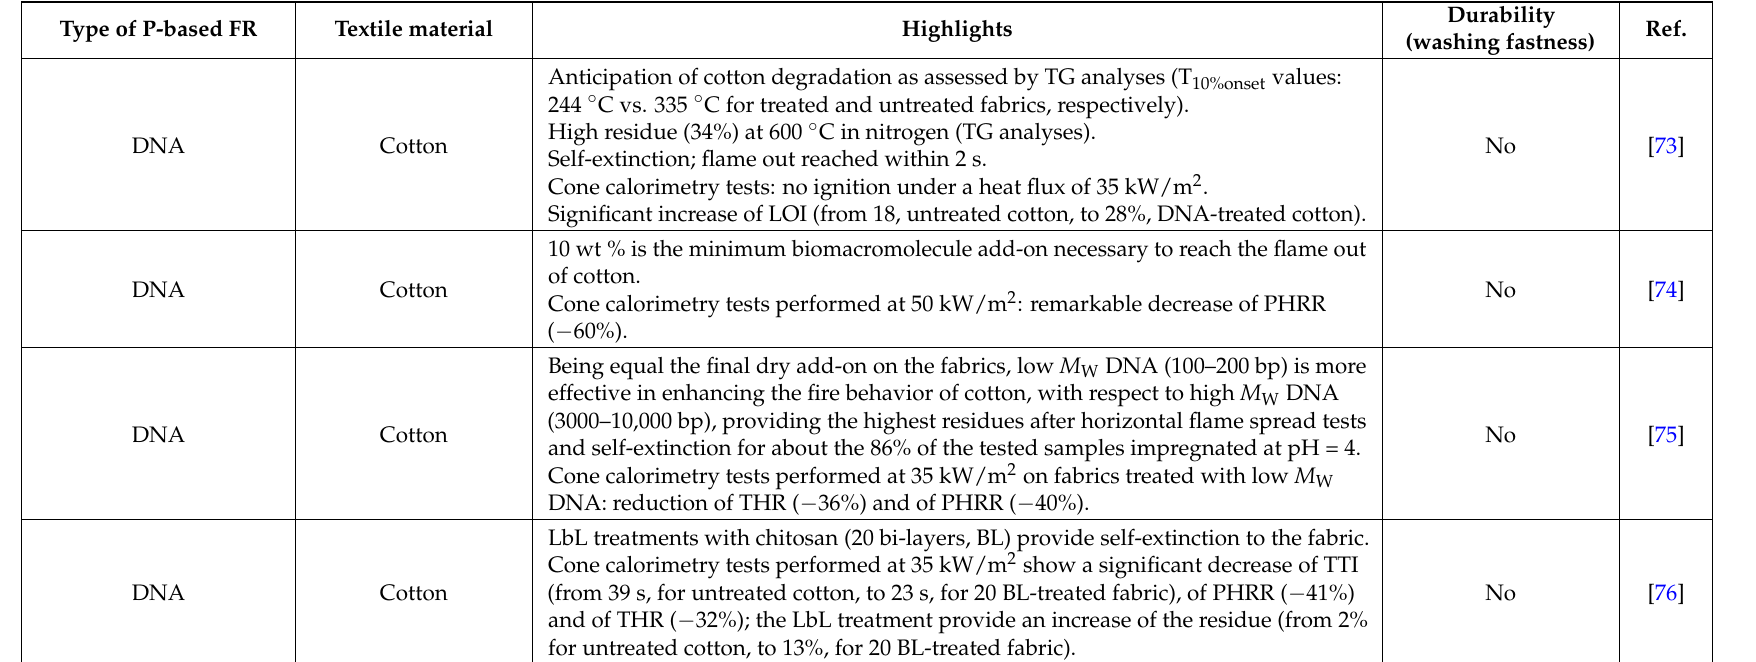
Durability Ref. (washing fastness)